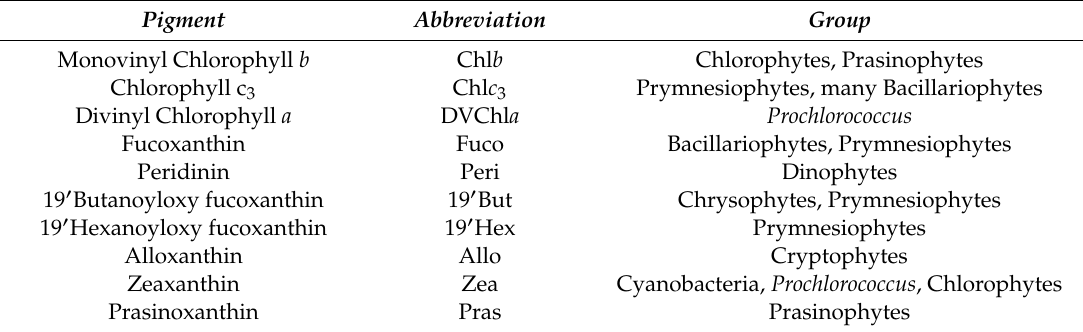
Table 2. Distribution of major taxonomically significant pigments in algal classes